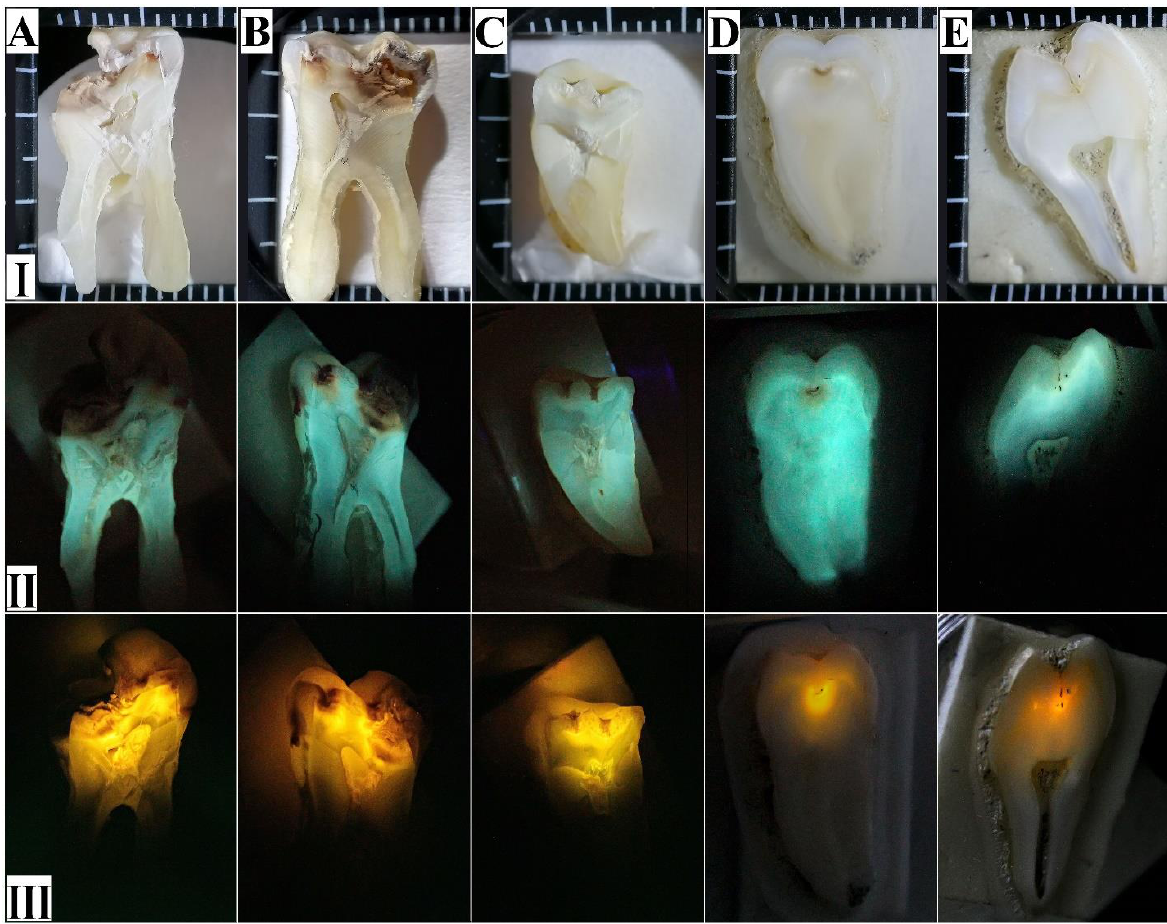
Figure 3. Images of the dental tissue samples with different degrees of development of the carious process: Line I—optical images; Line II—images of the reflectance signal obtained using the laser- induced fluorescence technique; Line III—images obtained using the laser-induced fluorescence technique after applying a notch filter. ( A – E )-Sample Group name (see Table 1).